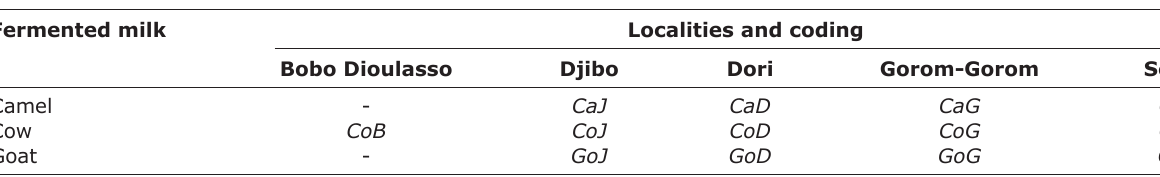
Table-1: Coding of samples.